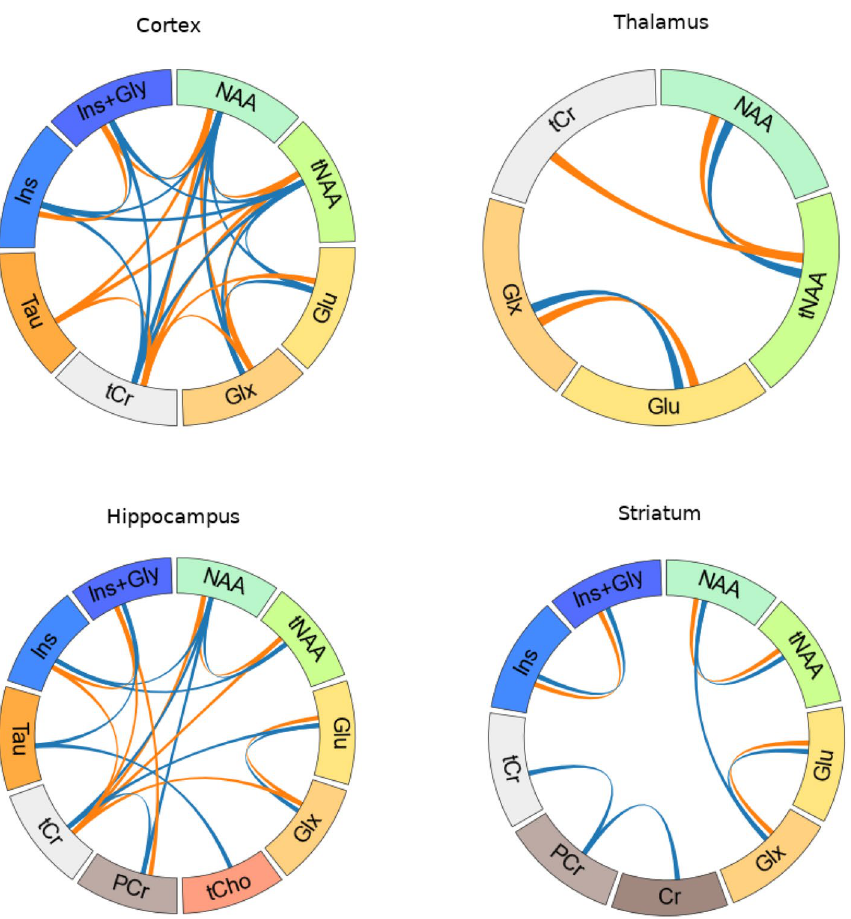
Figure 4. Intra-regional correlation. Correlation between the concentrations of metabolites within each region. Lines represent highly significant correlations ( p < 0.001). Blue lines, correlation in WT rats; orange lines: correlation in TgF344-AD